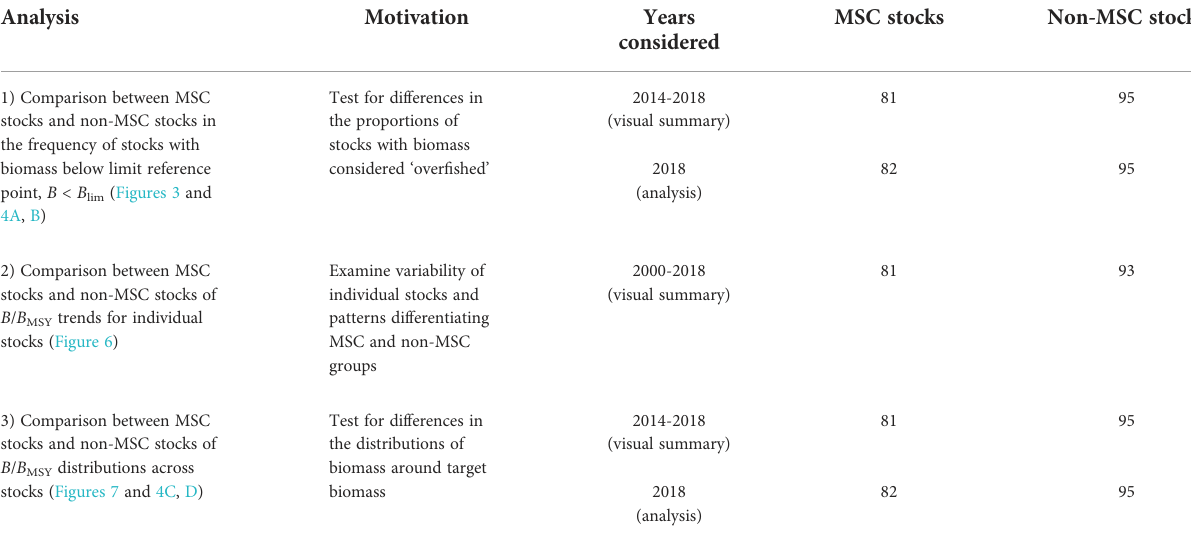
TABLE 1 Sample size of stocks in statistical analyses and visual